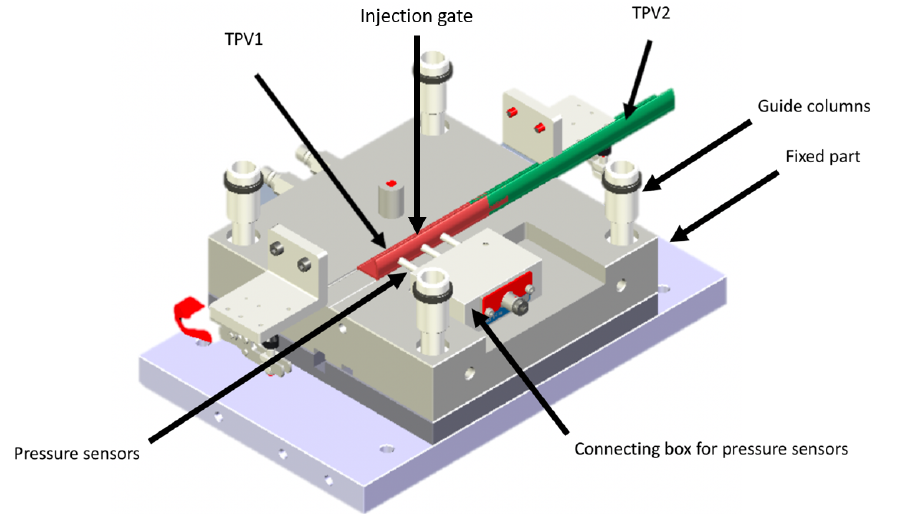
Figure 1. Overmoulding mould. The green and red profiles represent TPV2 and TPV1, respectively. Two pressure sensors are located at the inlet and at the outlet of the cavity. TPV1 is injected through a 3 mm diameter sprue.